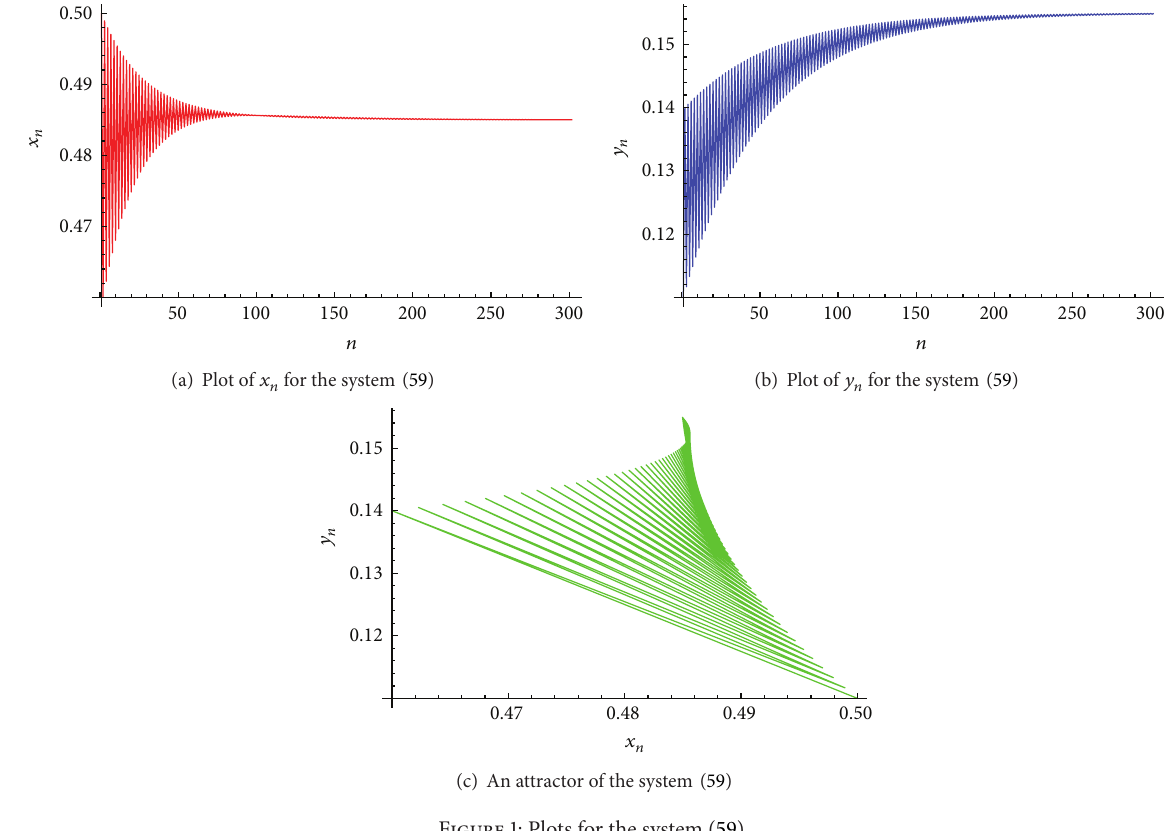
Figure 1: Plots for the system